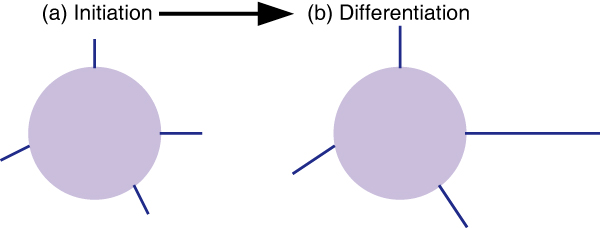
Neurite initiation and differentiation. (a) Cell surface inhomogeneities cause instabilities that lead to the formation of broad lamellipodia that condense into short neurites. (b) Competition for a growth-permitting chemical produced in the cell body can lead to the fastest growing neurite becoming the only outgrowing neurite, characteristic of axonal differentiation.